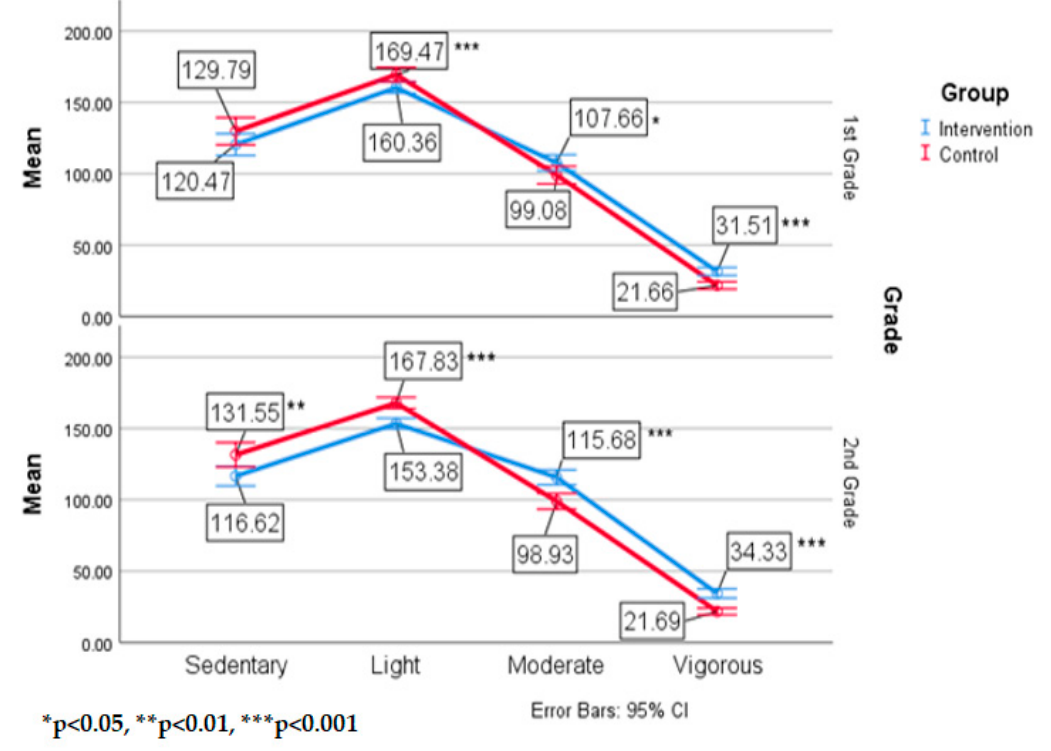
Int. J. Environ. Res. Public Health 2020 , 17 , x Figure 5. Means and standard deviations of MVPA by group by grade.